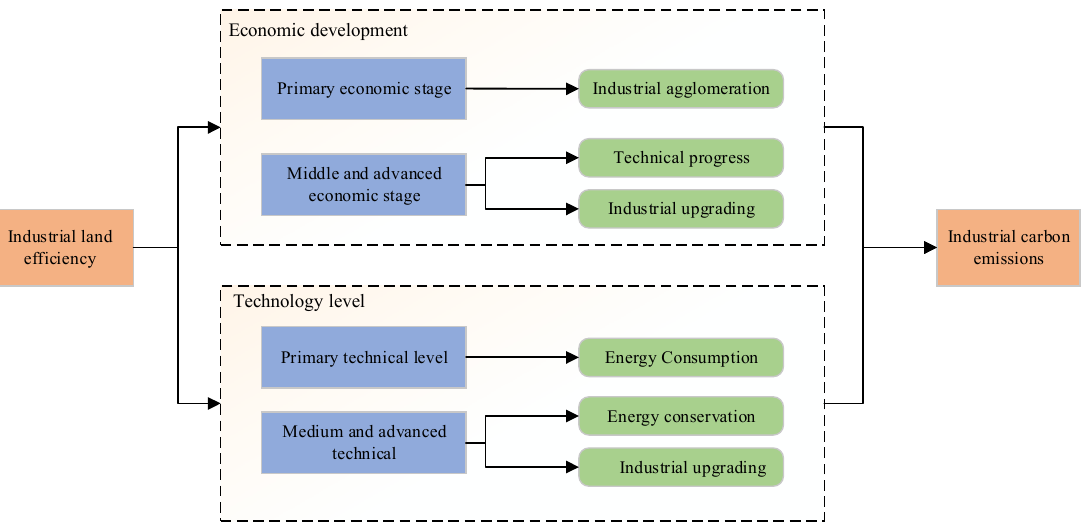
Figure 1. Threshold mechanism of industrial land use efficiency.